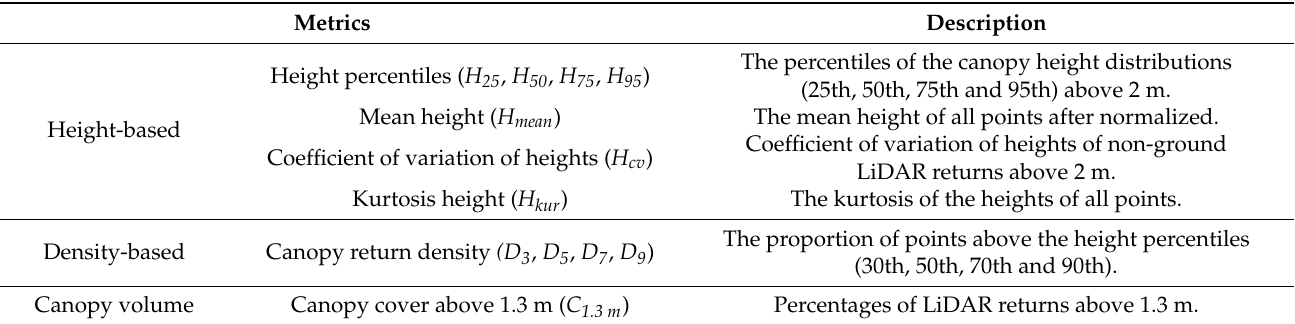
Table 3. Description of metrics derived from the three UAV-LiDAR